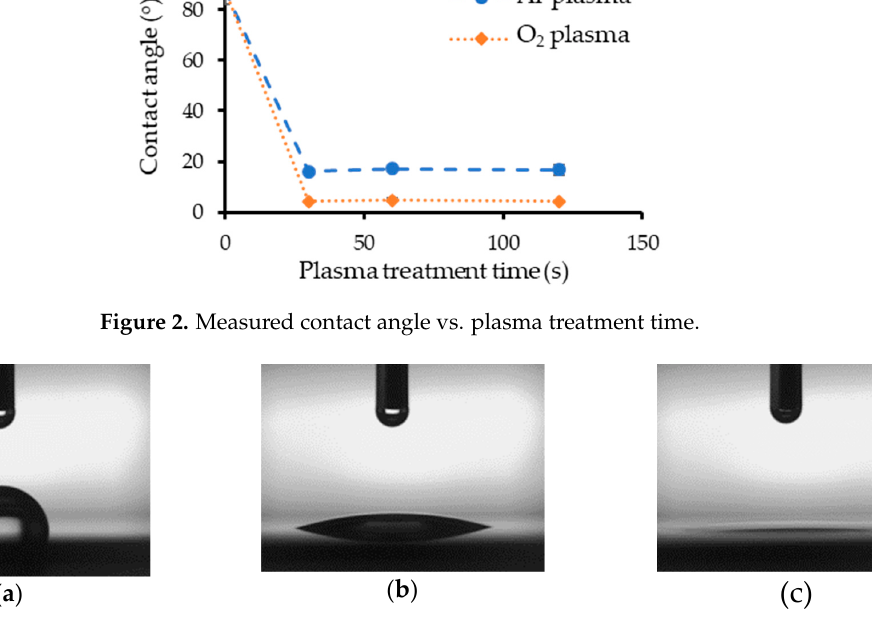
Figure 3. Typical images of measured contact angle: ( a ) without plasma treatment; ( b ) with 30 s Ar plasma treatment; ( c ) with 30 s O 2 plasma treatment.